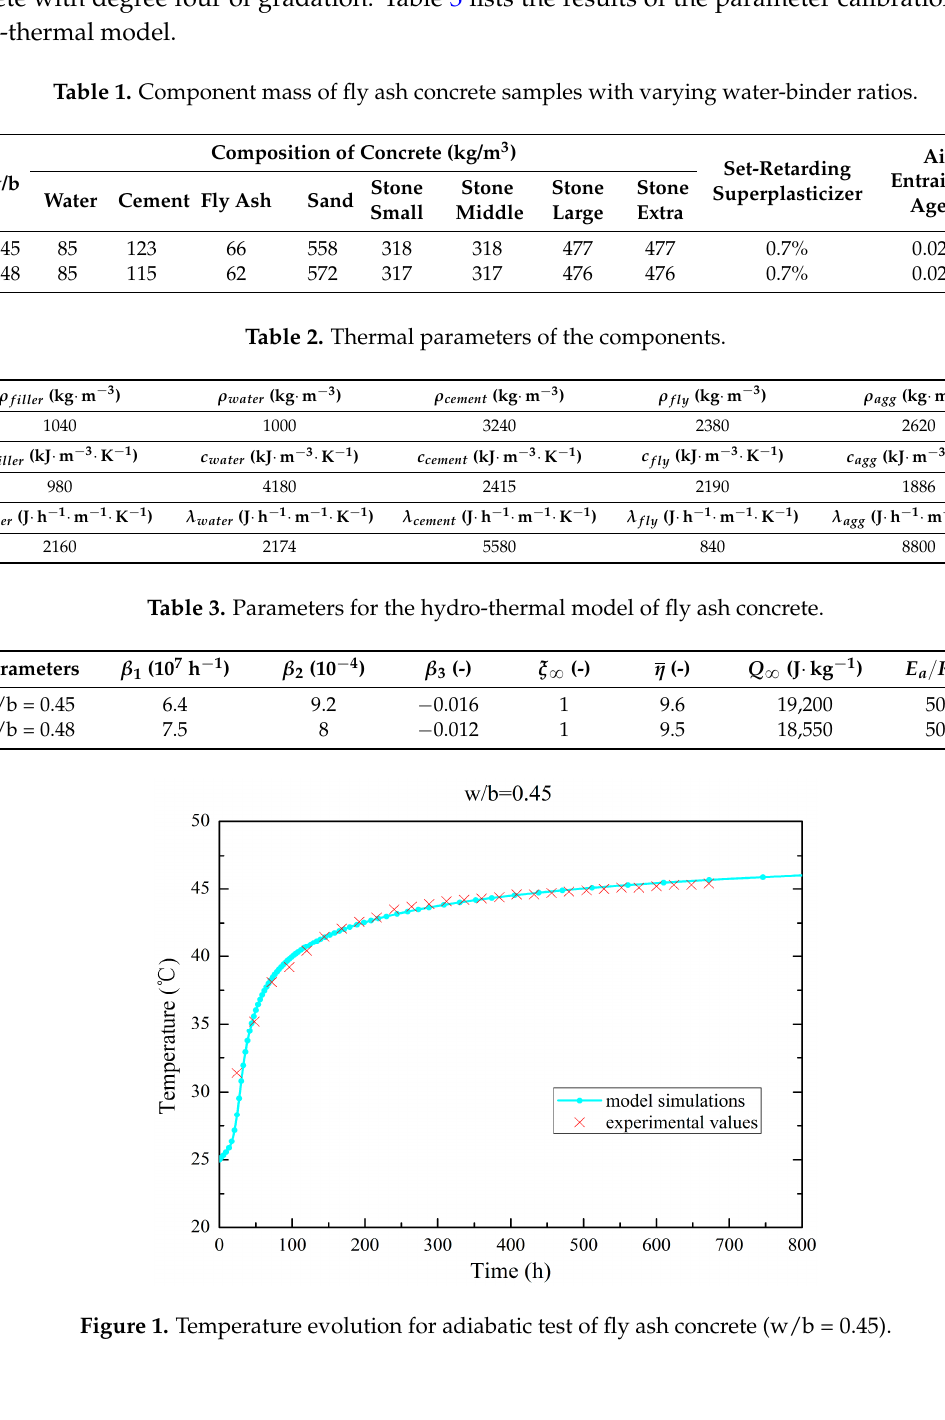
Figure 2. Temperature evolution for adiabatic test of fly ash concrete (w/b = 0.48). Mechanical tests on concrete are typically conducted under isothermal conditions; therefore, the hydration process is simulated under isothermal condition in this research, so the mechanical characteristics can be linked to the hydration degree rather than to time. Young’s modulus and the Poisson’s ratio evolution for isothermal test of fly ash concrete specimen are plotted in Figures 3 and 4.